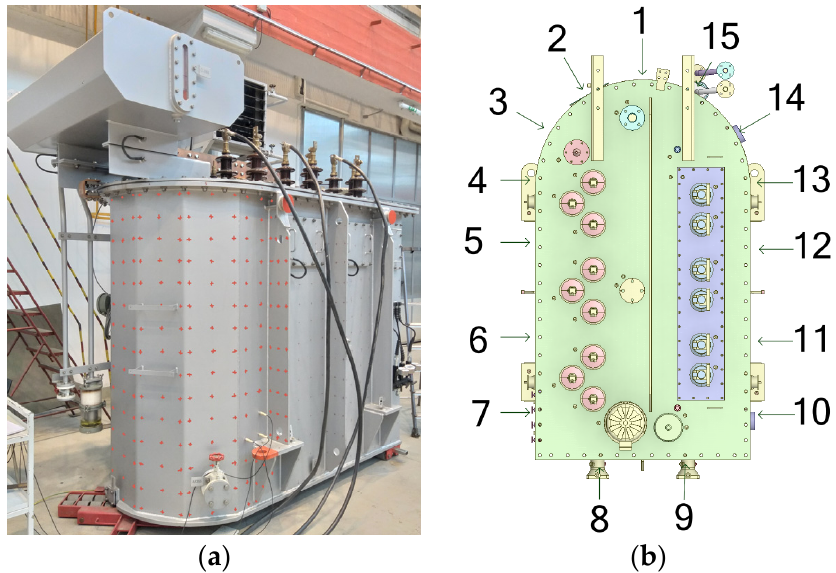
Figure 2. ( a ) Vibration measurement on the 5 MVA transformer experimental model with measure- ment points marked with red crosses (on a couple of surfaces crosses highlighted with photo editor) and three accelerometers in the short-circuit test, ( b ) Top view of the CAD model with numbers presenting transformer surfaces on which measurements are made.